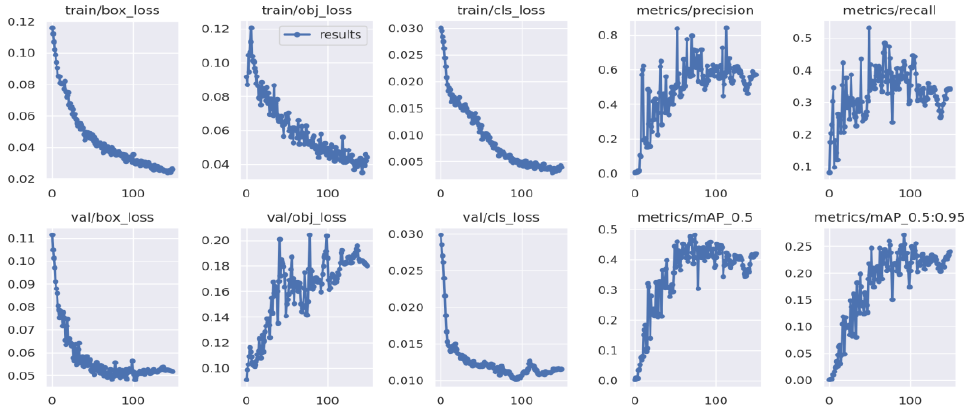
Figure 45. Setup output results using the YOLOv5s algorithm.